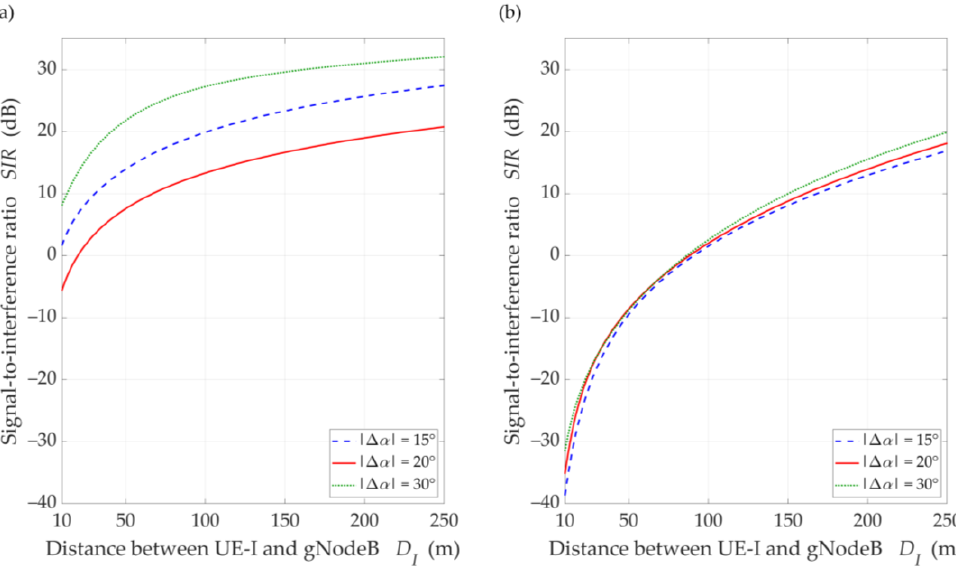
Figure 13. SIR versus distance D I for UL scenario, selected ∆ α = {15 ◦ , 20 ◦ , 30 ◦ }, D S = 100 m, under ( a ) LOS (TDL-D) and ( b ) NLOS (TDL-B) conditions.